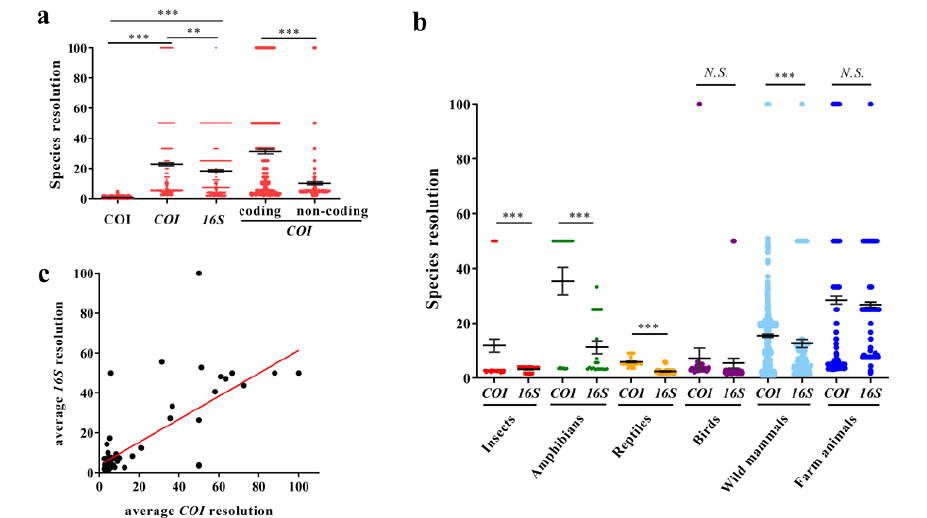
Figure 5. Species resolution provided by COI , 16S DNA barcodes and COI peptides (a) for different animal groups (b) as indicated. Species resolution of unique sequences is predicted using BLAST searches based on reference libraries in Genbank, where reference sequences might be deposited unequally for various species. (**) p<0.01; (***) p<0.001; (N.S.) not significant. (c) Correlation between the average resolutions of CO I and 16S for each species or breed of farm animals. Each dot is plotted according to the average values of resolution from all COI or 16S haplotypes belonging to the same species or breed. Spearman's correlation coefficient rho=0.76